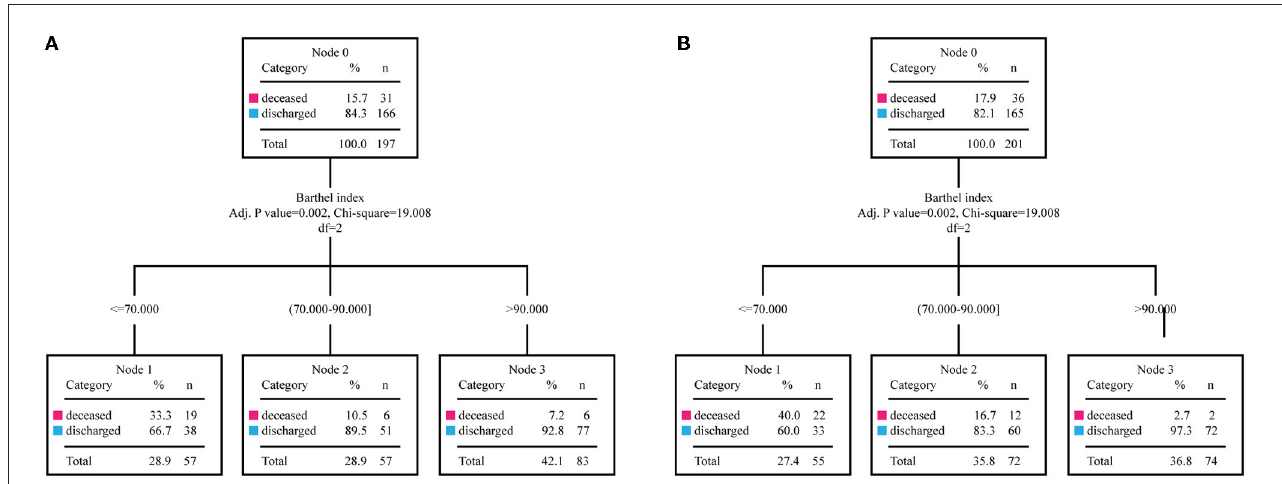
FIGURE4 The training samples and the test samples of the decision tree. By means of the split sample verification, the entire study population is divided into the training samples ( n = 197) and the test samples ( n = 201). (A) The training samples of the decision tree are divided into three groups which had different mortality. (B) The divided groups in test samples show similar mortality with the corresponding groups in the training